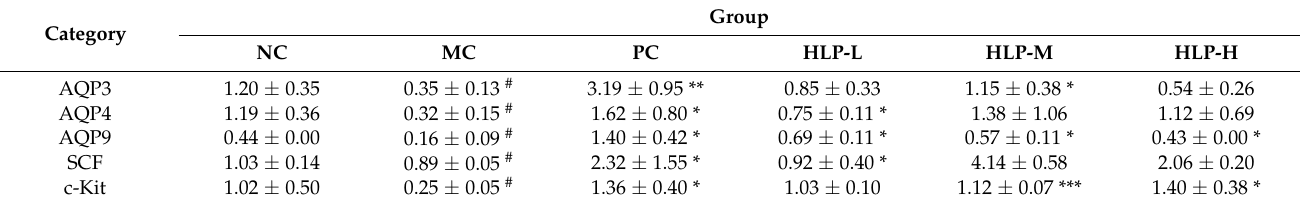
Table 1. Relative expression level of water channel proteins (AQP3, AQP4 and AQP9), c-Kit, and SCF.